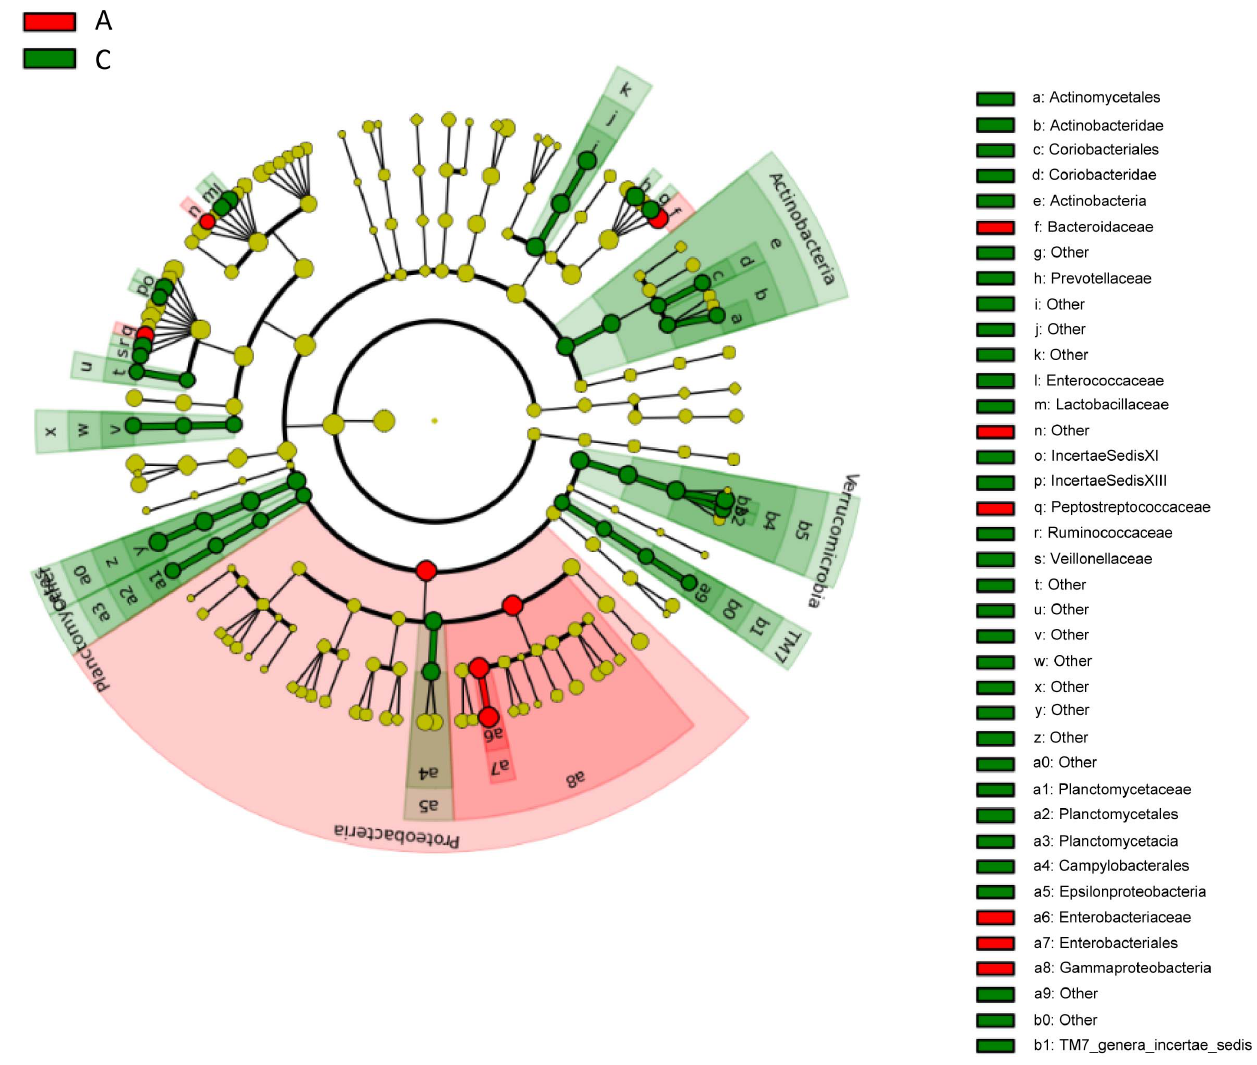
Figure 6. LEfSe results on foal microbiome. Rotary phylogenetic representation of the predominate microbial composition of fecal samples from foals at 2 days of age (A, red) and 30 days of age (C, green) [32].